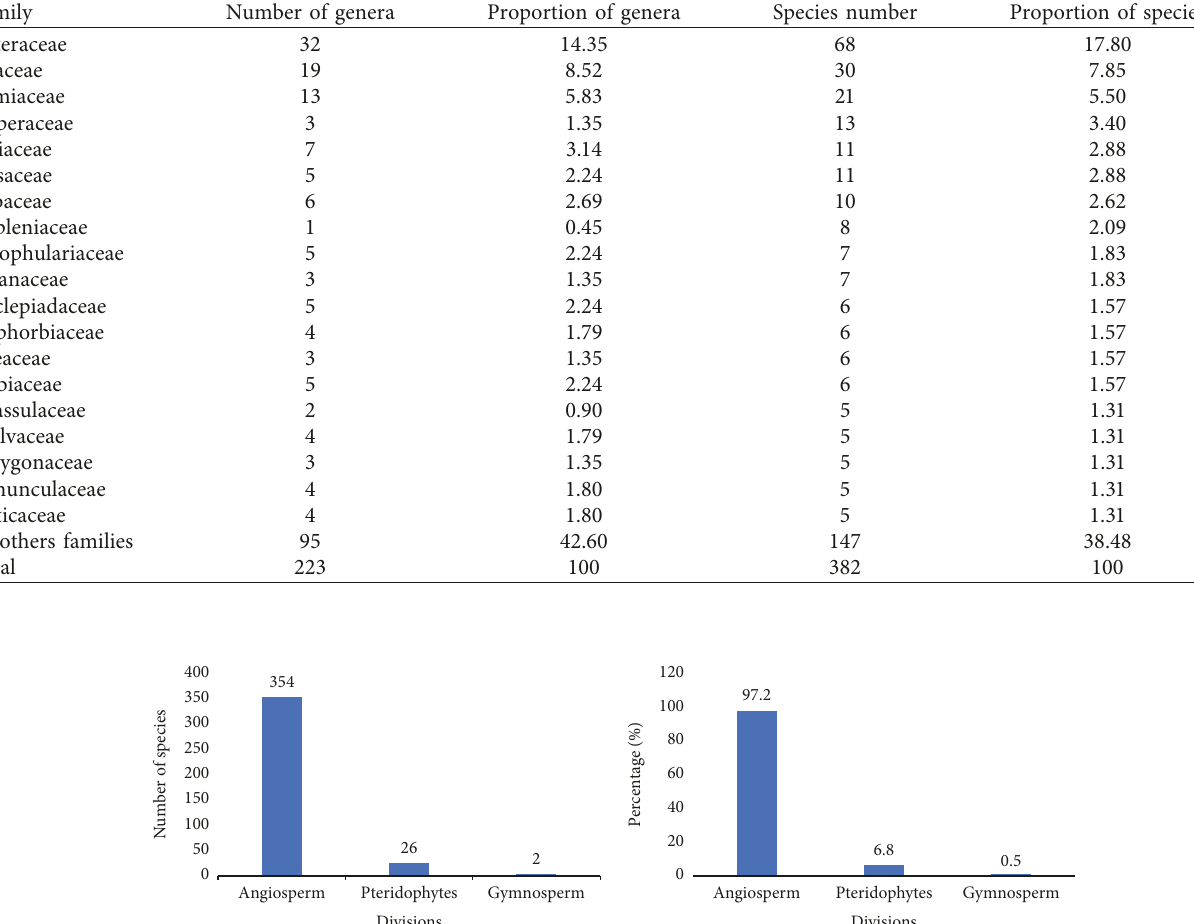
Table 1: Floristic richness of the study districts (woredas) recorded of Arsi-Bale Massifs with species number in decreasing order. Family